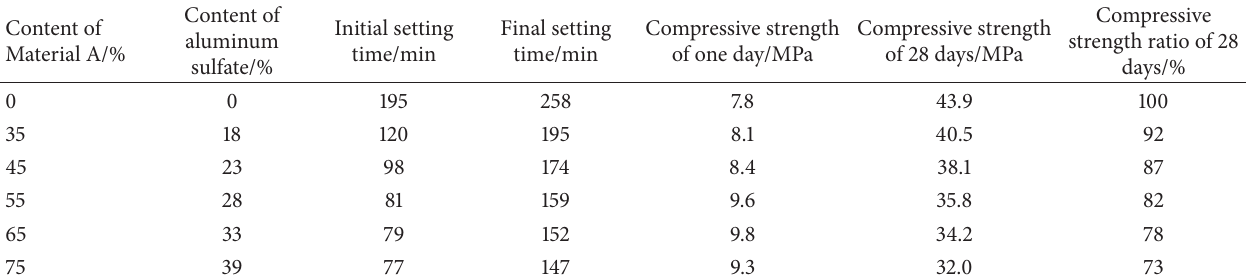
Table 6: Effects of aluminum sulfate mass content on the setting time and strength of